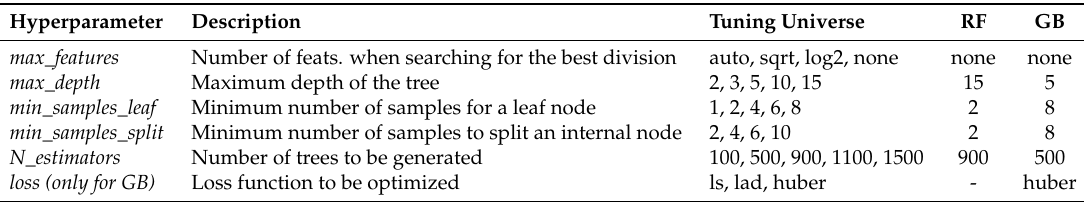
Table 4. Optimal hyperparameters (last two columns) and their search spaces for the RF and GB ensemble models.